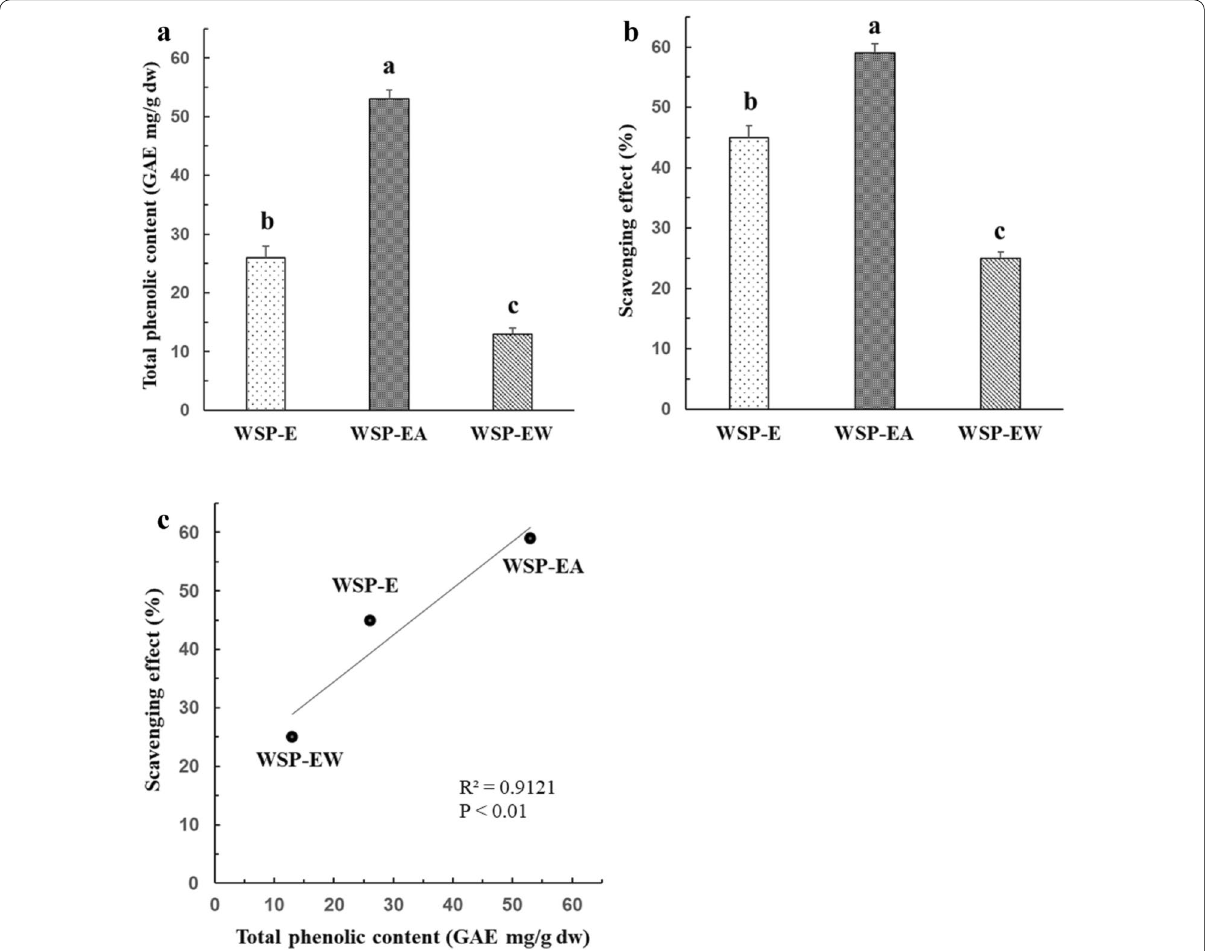
Fig. 2 Total phenolic content, DPPH radical‑scavenging activity and relationship between antioxidant activity and total phenolic content in WSP. A Total phenolics of sweet potato extracts. B Percentage scavenging activity of sweet potato extracts. C Correlation between % scavenging activity and total phenolic contents. GAE gallic acid equivalent, WSP-E white sweet potato ethanol extract, WSP-EA white sweet potato ethyl‑acetate fraction, WSP-EW white sweet potato water fraction. Values were presented as mean SD of 3 independent experiments performed in triplicate, ± and were analyzed using one‑way ANOVA, followed by a post hoc Tukey’s test for multiple comparisons. Different letters above the error bars indicate significant differences among treatments ( P <